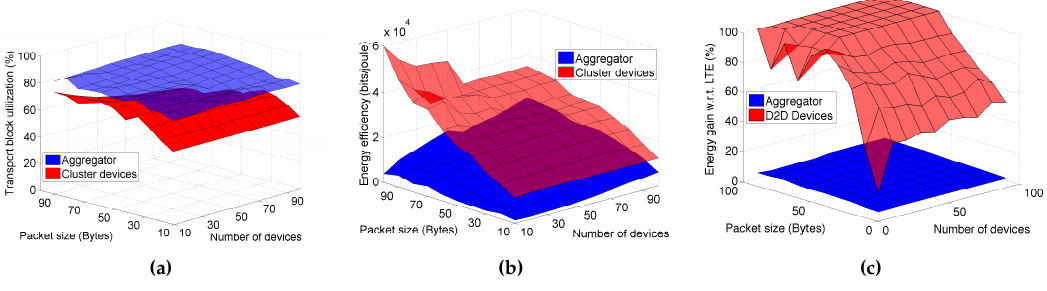
Figure 7. Performance for varying number of devices and data size: Aggregator vs. cluster devices. ( a ) Transport Block utilization; ( b ) Energy efficiency; ( c ) Energy consumption.